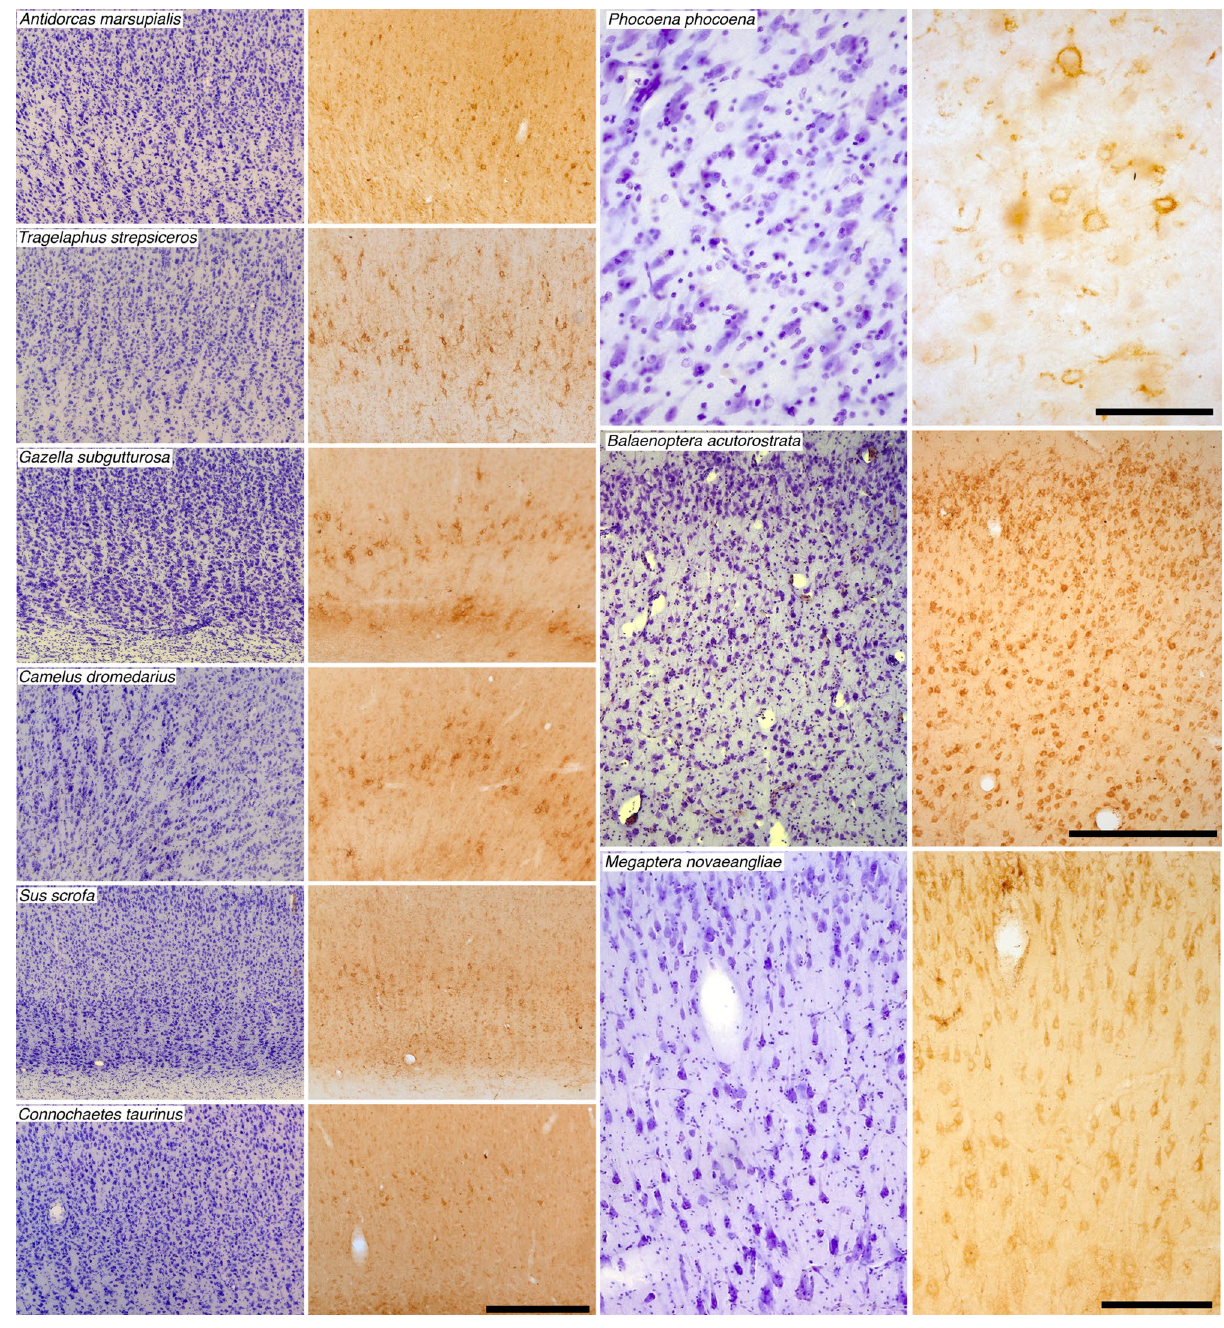
Figure 1. UCP1 immunostaining in cetartiodactyl cerebral cortex. Photomicrographs of Nissl stained (purple colored images) and UCP1-immunostained (brown colored images) cortical sections in a range of artiodactyl (two left columns) and cetacean species (two right columns). Note in all cases the presence of UCP1- immunostained cortical neurons, but in the artiodactyls these are limited to the lower layers of the cortex, while almost all cortical neurons from all layers are immunopositive in the cetaceans. Scale bar in the UCP1- immunostained section of Connochaetes taurinus equals 500 µm and applies to all artiodactyl images. Scale bar in the UCP1-immunostained section of Phocoena phocoena equals 100 µm and applies to both images. Scale bar in the UCP1-immunostained section of Balaenoptera acutorostrata equals 500 µm and applies to both images. Scale bar in the UCP1-immunostained stained section of Megaptera novaeangliae equals 250 µm and applies to both